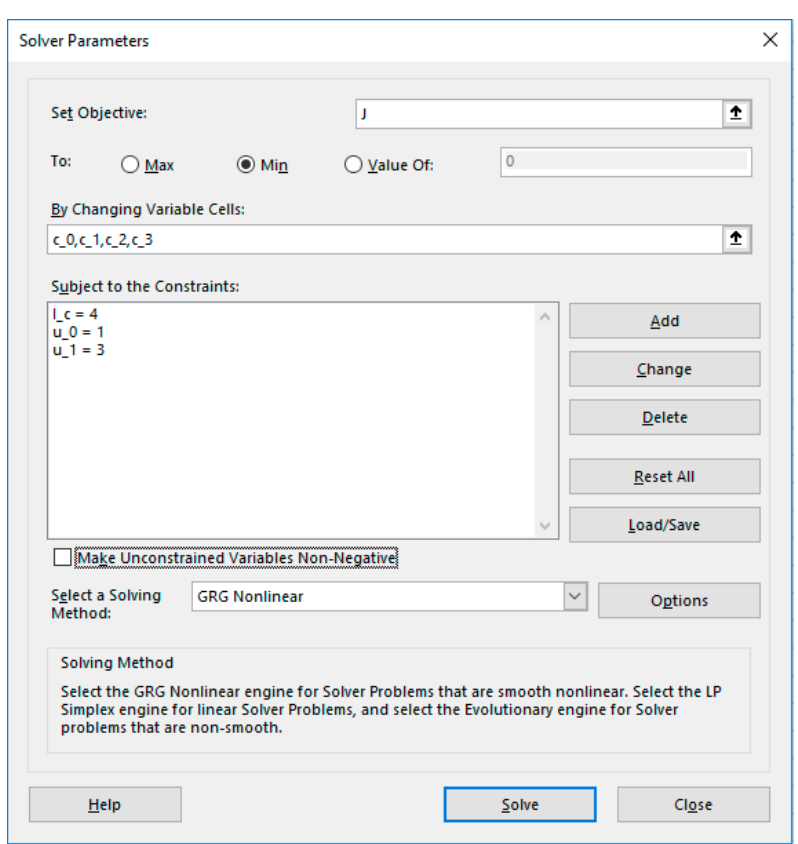
Figure 2. Spreadsheet parametrized model for problem 3.1.